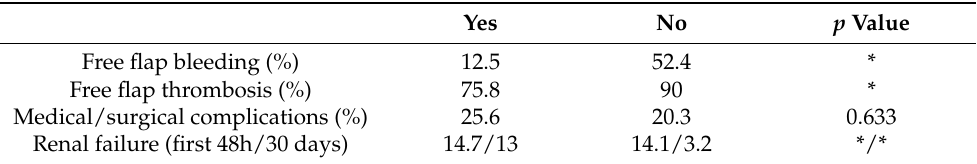
Table 5. Colloids and complications.